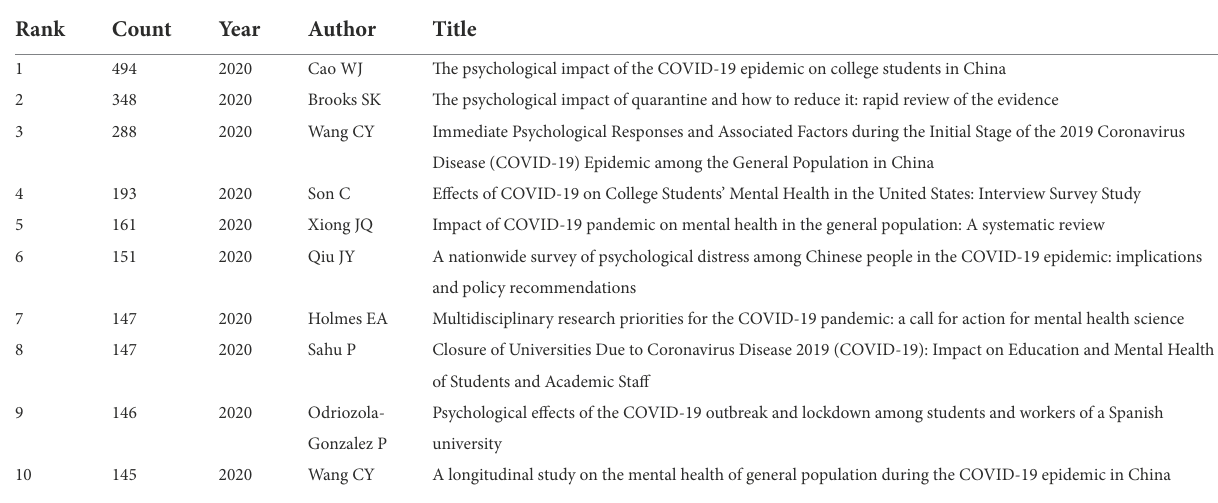
TABLE 1 Top 10 co-cited references in mental health of students in